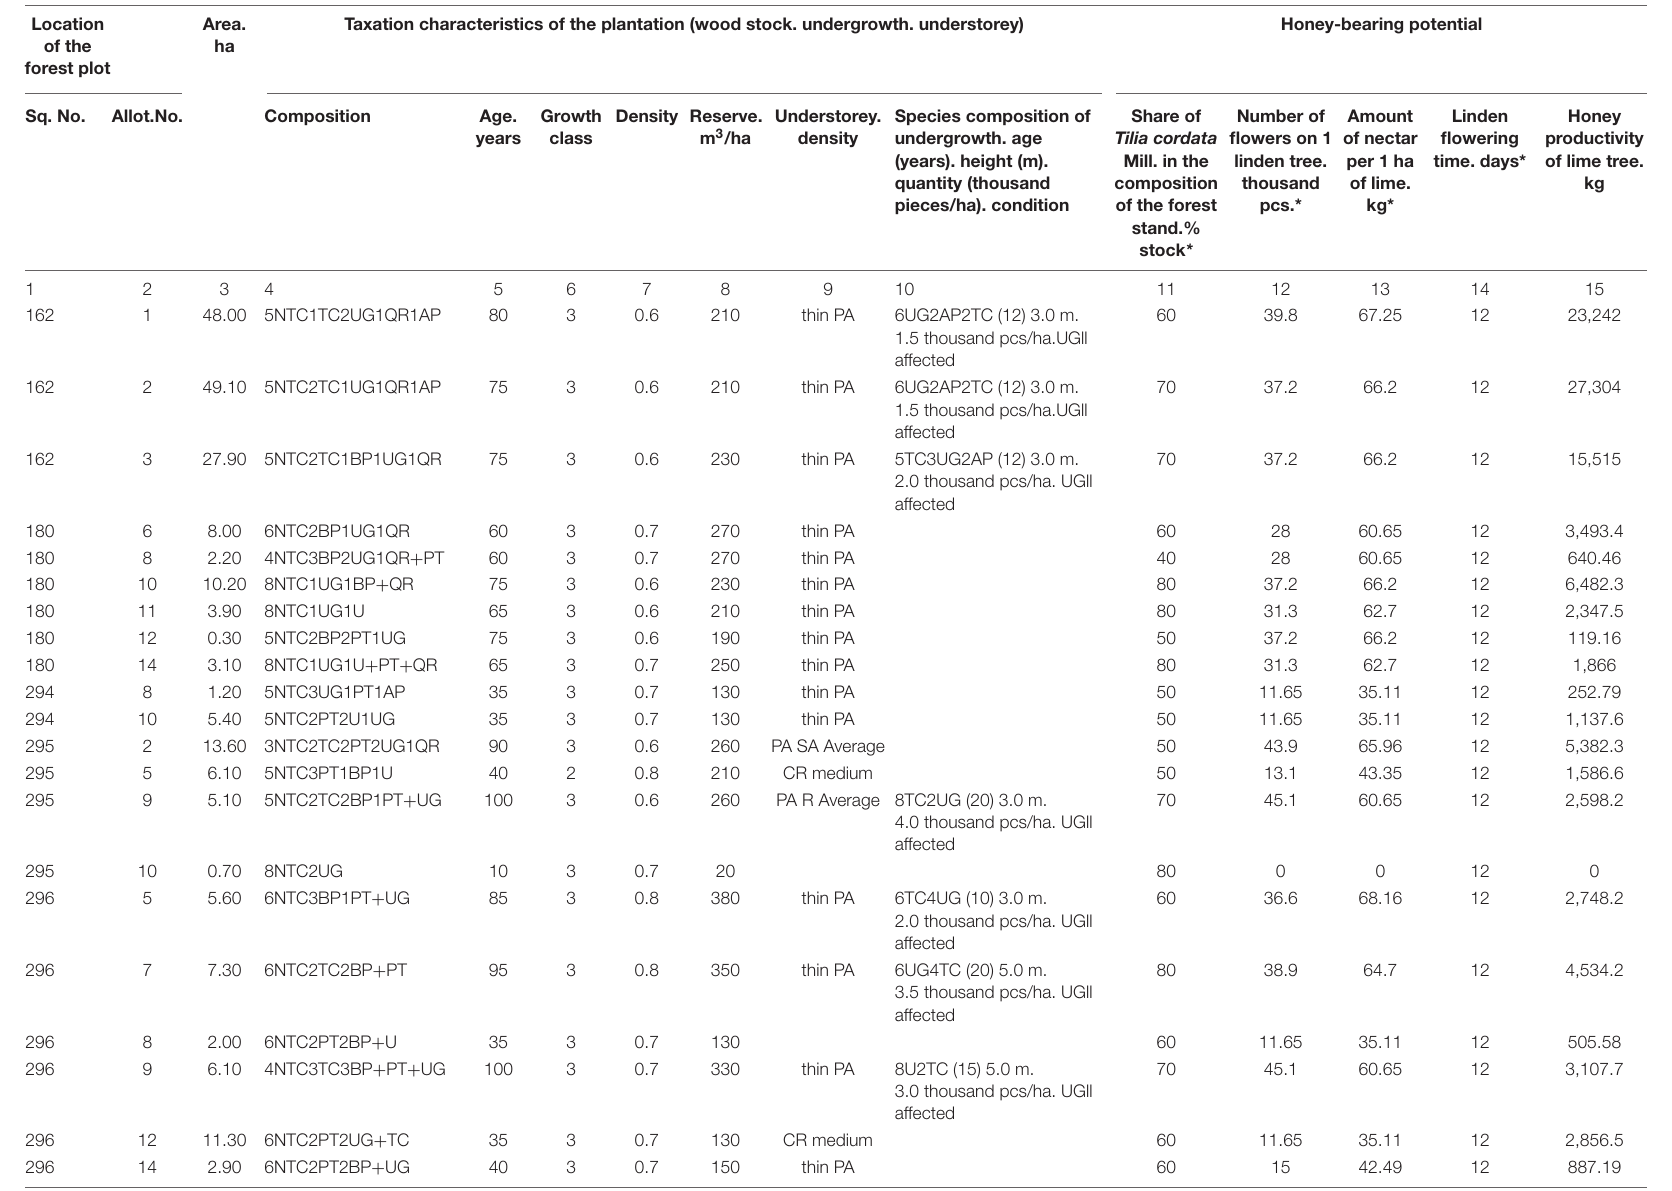
TABLE 2 | Honey-bearing potential of specially protected areas (SPA) – “honey-bearing forest areas” (fragment). Object: Iglinskoe. Ulu-Teliakskoe forest districts. Location Area. Taxation characteristics of the plantation (wood stock. undergrowth. understorey) Honey-bearing potential of the ha forest plot Sq.